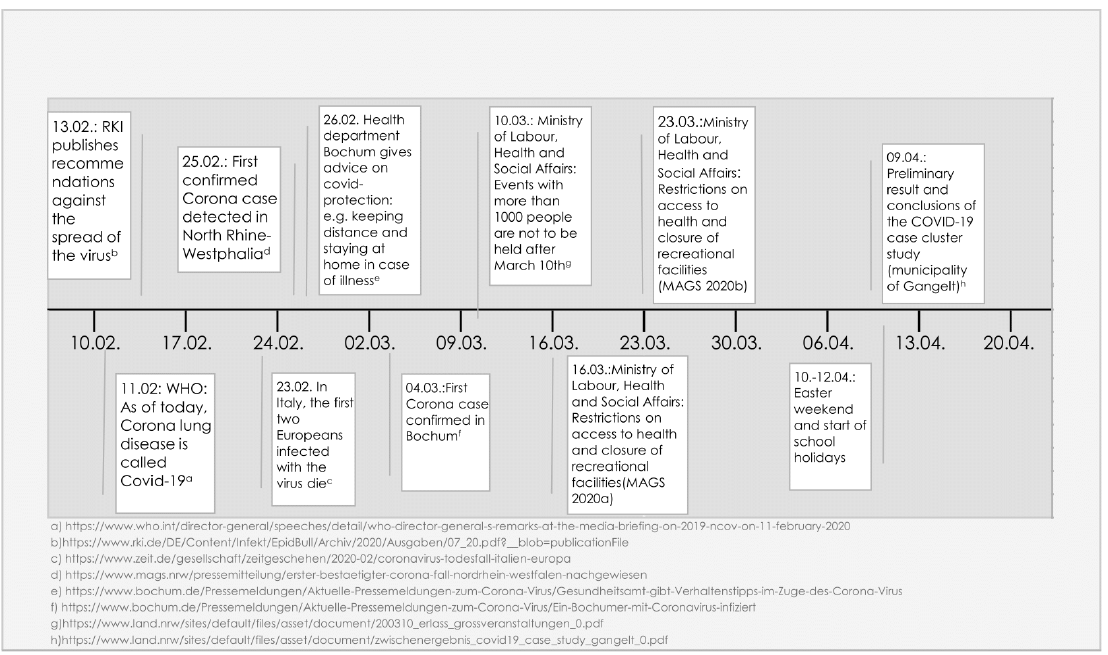
Figure A2. Relevant events and press